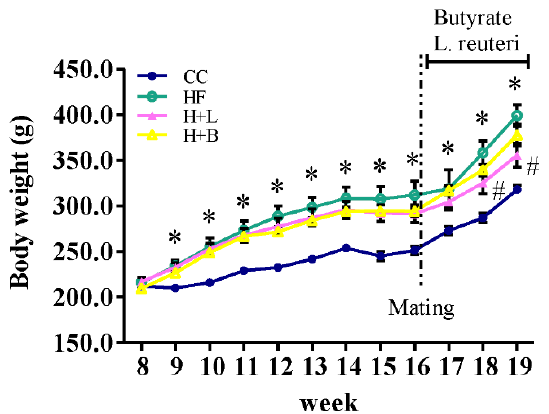
Figure 1. The change in body weight (BW) of dams with the control diet (CC), high-fat diet (HF), maternal high-fat diet with Lactobacillus reuteri treatment after mating (H + L), and maternal high-fat diet with sodium butyrate treatment after mating (H + B). A significant difference was observed after 1 week of diet manipulation. * Compared to the CC group, p < 0.05; # compared to the HF group, p < 0.05. The detailed data are shown in Supplementary Table S2.